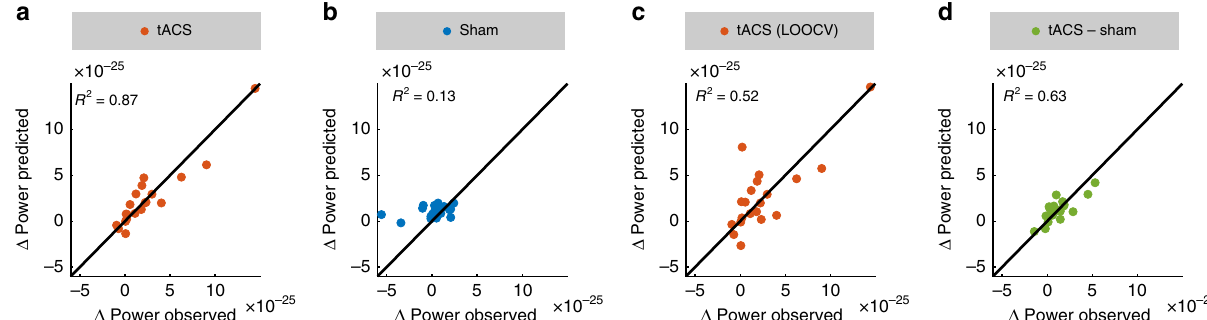
Fig. 5 Model predictions. Scatterplots depict the power increase from the baseline to the post-stimulation block predicted by the statistical models, plotted against empirically observed values. Each dot represents data of a single subject. The diagonals indicate the line of perfect prediction (predicted Δ power = observed Δ power). The distance of each data point from the diagonal indicates the residual prediction error. a Predicted and empirical power increase for the tACS group. b Predicted and empirical power increase in the sham group. c Power increase predicted for each subject in the tACS group by the cross-validated model. For each data point n i the model was trained on n − 1 observations to predict the remaining i th observation. d Individually sham-controlled tACS effect (power increase relative to baseline after tACS − power increase relative to baseline after sham) on source-level α -power predicted by measures of tACS targeting. Source data are provided as a Source Data fi